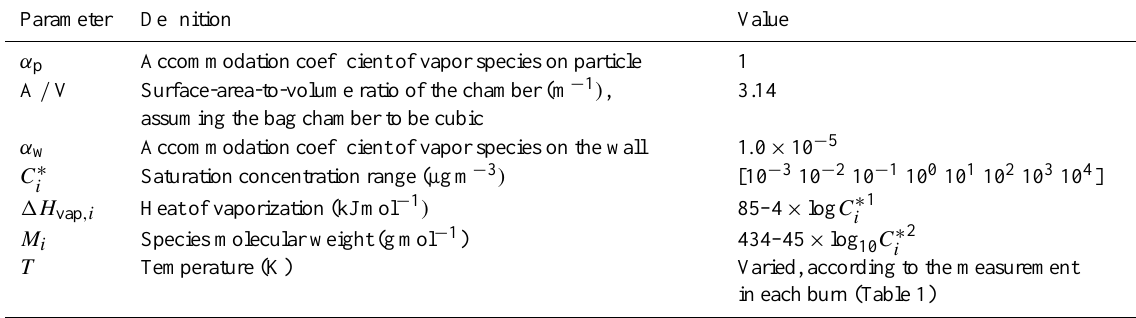
Table 2. Parameters used in the base-assumption